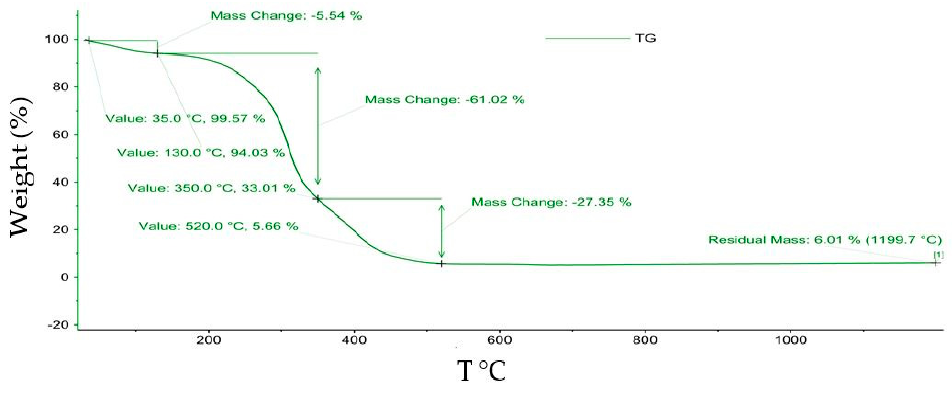
Figure 8 . Curve of TG regarding maize stalk before adsorption process.